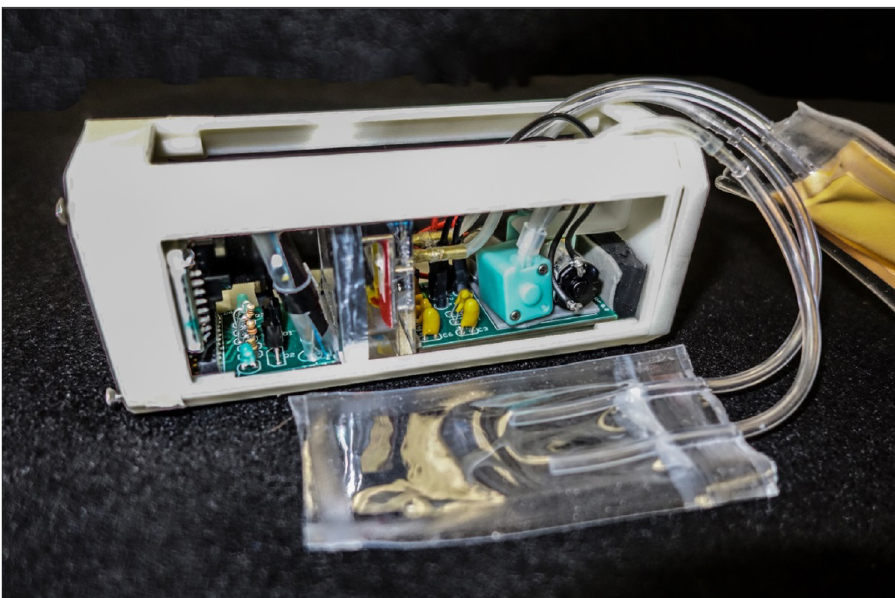
Fig. 6 Fluidic density showing the innovated polycarbonate chamber, low pro fi le water bag, vented pressure bag, redundant peristaltic pumps, and anti-glare jackets, which are highlighted in purple in Fig. 5